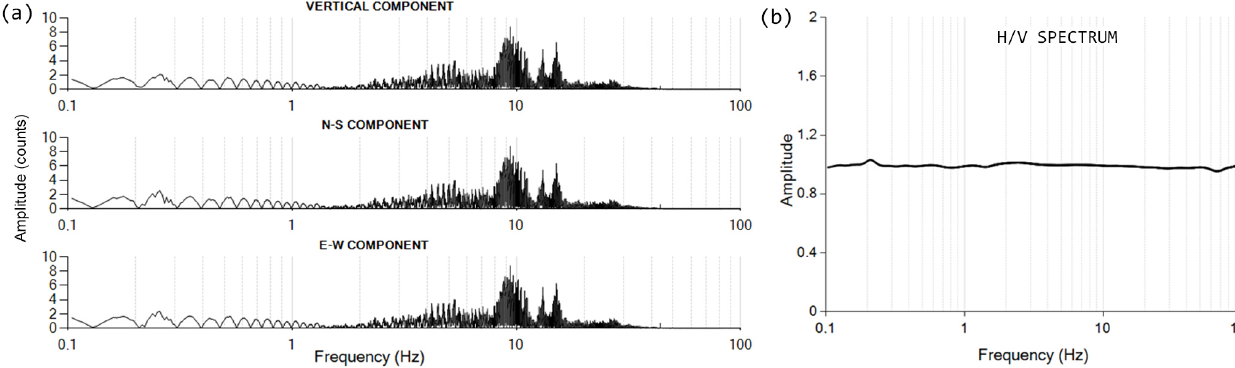
and 60 dB, were used in the signals recorded with